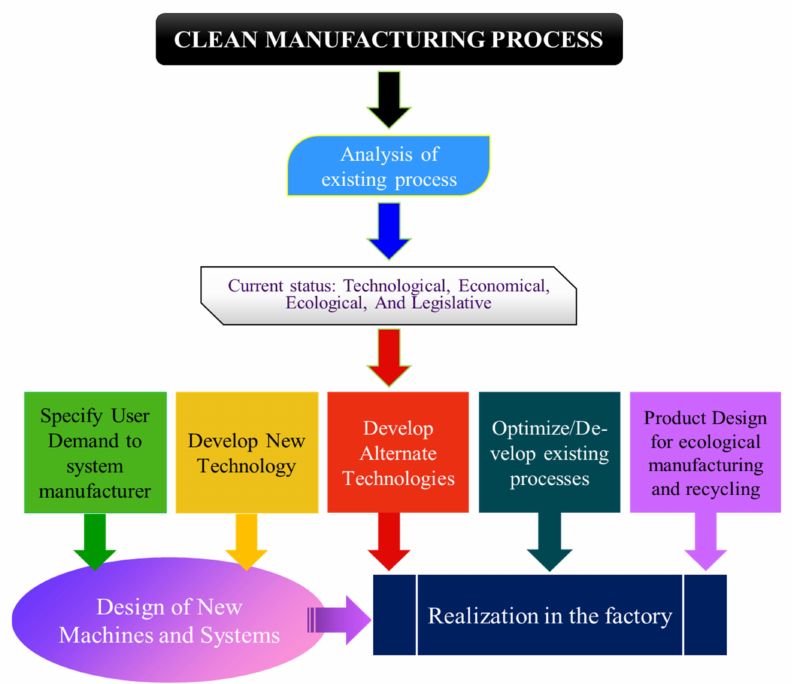
Figure 4. Implementation of Clean Manufacturing process, reprinted with permission from ref. [31]. Copyright 2010 Elsevier Ltd.